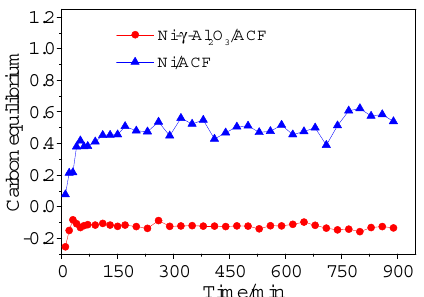
Figure 6. Calculation of carbon equilibrium. GHSV: 24,000 mL·h − 1 ·g − 1 ; detailed reaction conditions: CH 4 : 50 mL/min; CO 2 : 50 mL/min; N 2 : 100 mL/min; catalyst dosage: 0.5 g; temperature: 750 °C; test time: 900 min.